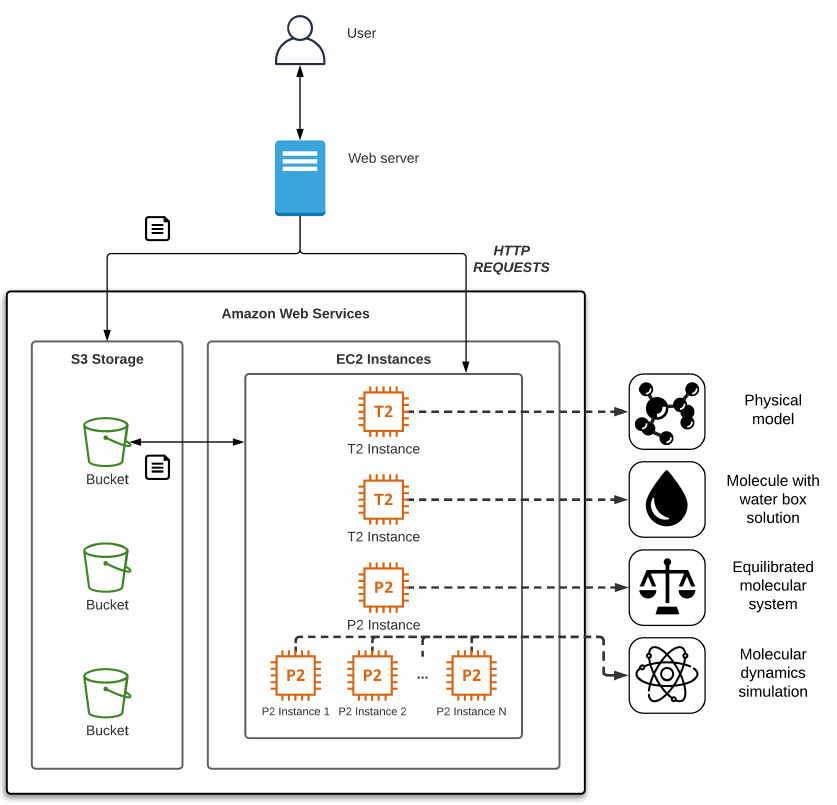
Figure 5. Detailed diagram of the testbed architecture based on Figure 2 using the AWS cloud computing environment.